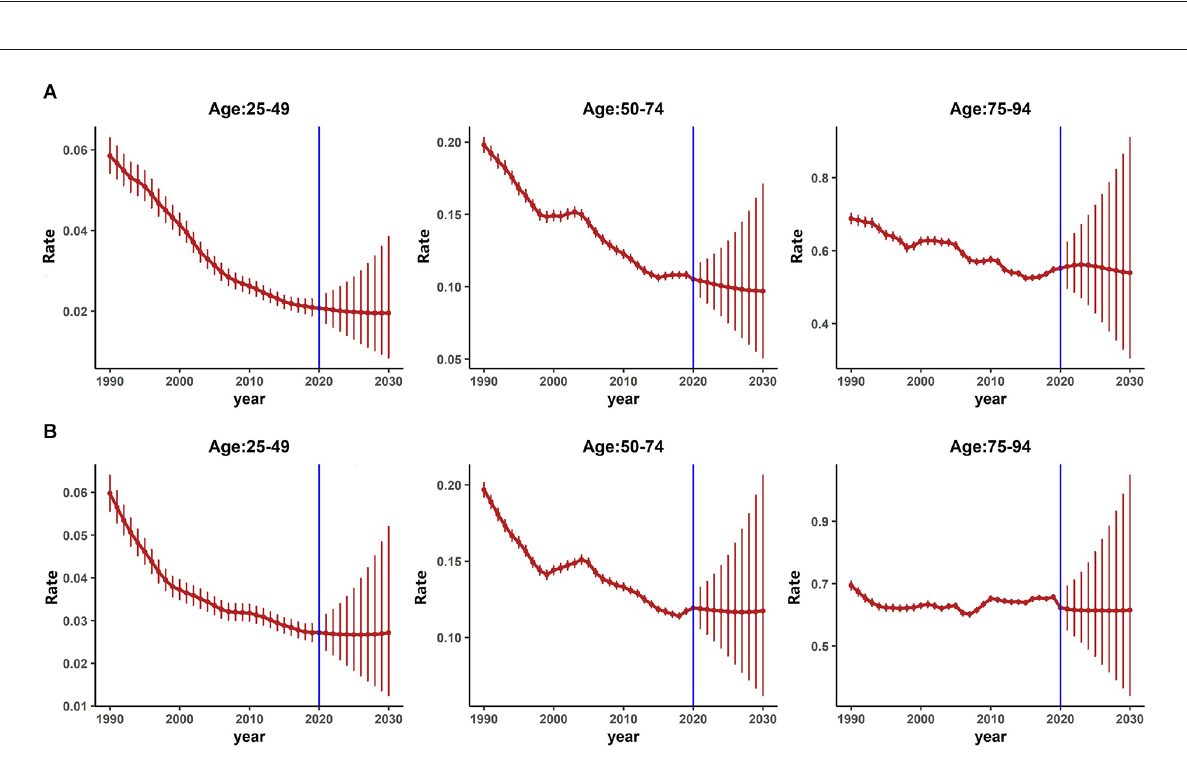
to the deepening aging of China’s society. The age of 60–65 is considered the beginning of aging, which is also equivalent to the retirement age in most countries (Fereshtehnejad et al.,